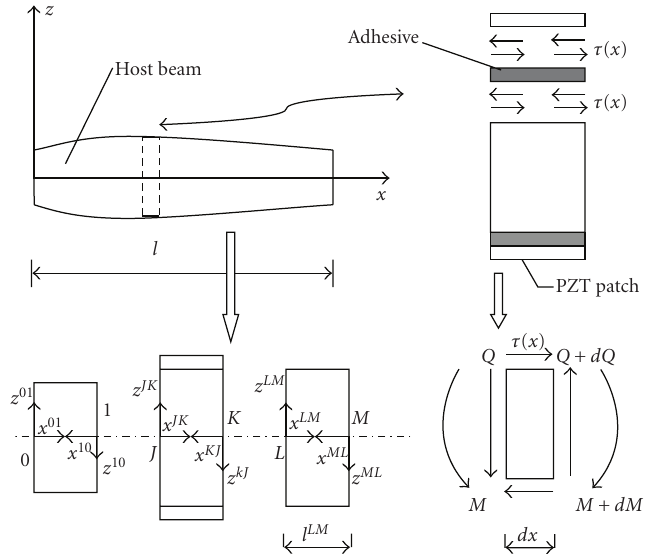
Figure 3: Nonhomogeneous beam with adhesively bonded PZT patches and local